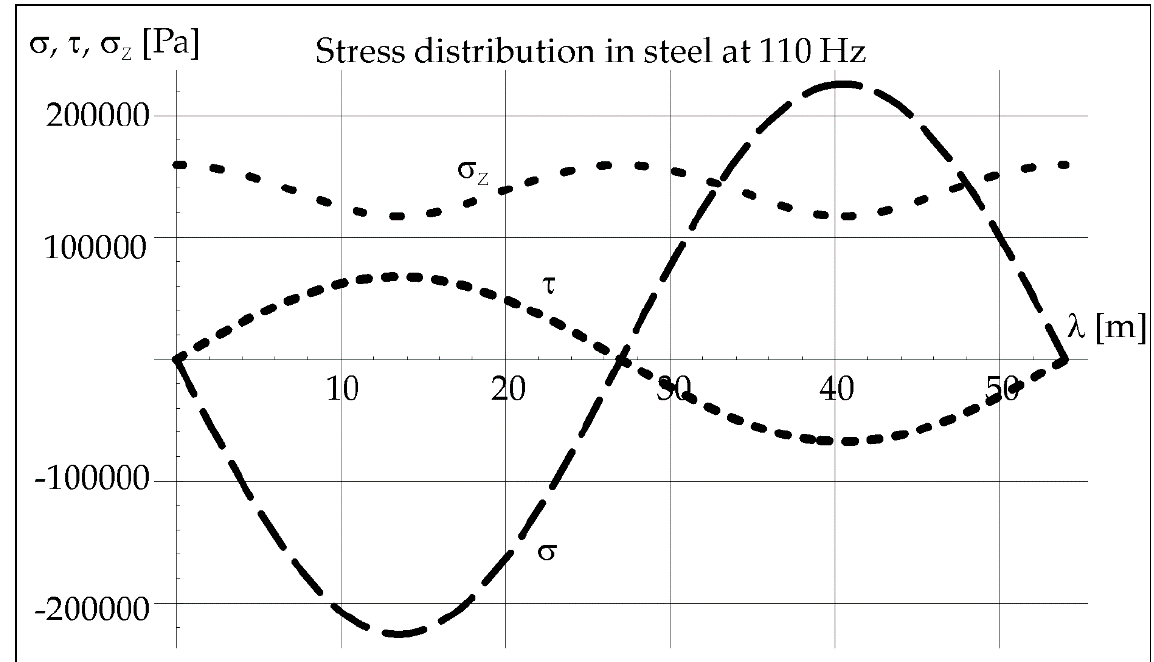
Figure 13. Stress distribution in steel at 110 Hz. The normal, shear, and equivalent stresses in steel oscillate on a significant wavelength (Figure 13). In this case, it is 54 m (Table 1) and results from the vibration frequency 110 Hz. As mentioned earlier, the acoustic pressure of the generated sounds was constant and amounted to 2 Pa. In the case of vibrations with a resonance frequency of 1385 Hz, the amplitude calculated from Equation (2) was (5.77 × 10 − 7 m), which is shown in Figure 14.